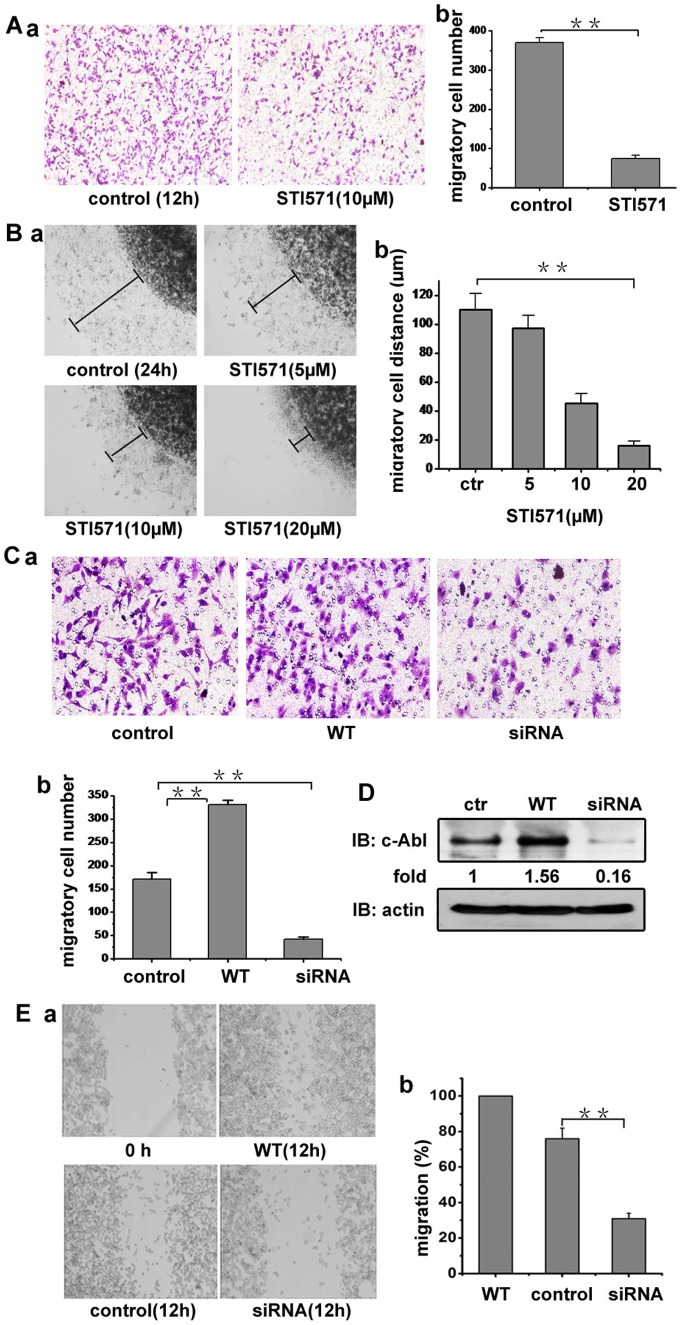
c-Abl kinase affects PDGF induced A375 migration.(A) a, the serum-starved cell suspension, with or without 10 µM STI571 (c-Abl kinase inhibitor), was seeded onto 0.8 μm diameter upper transwell chamber, which was coated with fibronectin. Free-serum medium with 50 ng/ml PDGF was put into the lower chamber to induce cell migration. b, migrations were determined by counting cells in randomly selected five microscope field per well. Bars represent mean ± S.D. (B) the effects of different concentration of STI571 on cell migration. The migration experiment of A375 cells out of agarose drop explants treated with or without STI571 was conducted. After 24 h, the distant of migration was measured using inverted microscope fitted with a rule in eyepiece. a, Cell migration rate was evaluated by the distance of the leading edge of migrating cells from the edge of agarose droplet. b, The distance of cell migration was measured, the extent of cell migration within the drop  =  [(total area/drop area) ×100] –100. (C) A375 cells were transfected with WT c-Abl expression vector or specific siRNA targeting c-Abl. The migration experiment of A375 cell or tansfected cells was performed in transwell plates (b was the statistic value of a). (D) A375 cells or cells transfected with WT c-Abl or c-Abl specific siRNA were lysed (For the transfected cells, cells were lysed after 24 h transfection). Lysates were blotted with c-Abl and actin antibodies. (E) a. A375 cells or the cells transfected with WT c-Abl or c-Abl specific siRNA were plated into 24-well plated and allowed to form a confluent monolayer. After overnight serum starvation, the cell monolayer was “wounded” with a pipette tip. The cells were incubated with DMEM containing 20 ng/ml PDGF and then imaged. b. Cell migration was determined as shrinkage of an average gap area. Bars represent mean ± S.D of three independent experiments. **, p<0.01, ***, p<0.001 with respect to control.